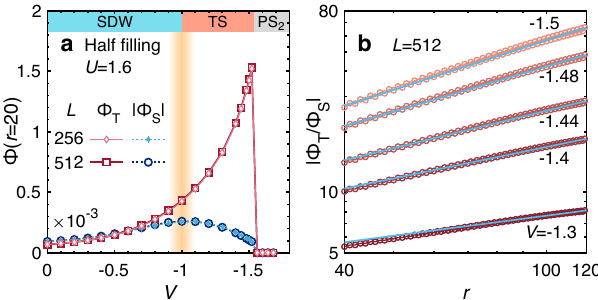
Fig. 4 Dominance of the triplet over singlet pairing in the half- fi lled TS phase. Here we show the data of U = 1.6. a Singlet and triplet pairing correlations at a fi xed (long) distance r = 20. The yellow strip represents the transition point V c ≃ − 1 from spin density wave (SDW) to triplet superconducting (TS) phase. b The calculated ratios ∣ Φ T / Φ S ∣ , plotted in a log-log scale, exhibit excellent agreement with the scaling r K ρ (cid:2) 1 (blue solid